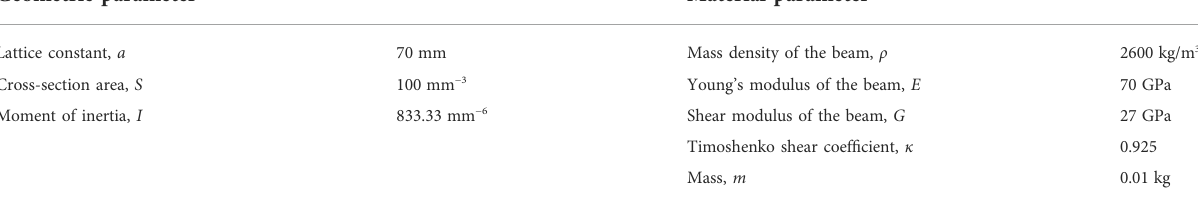
TABLE 6 Geometrical and material parameters for the QZS locally resonant